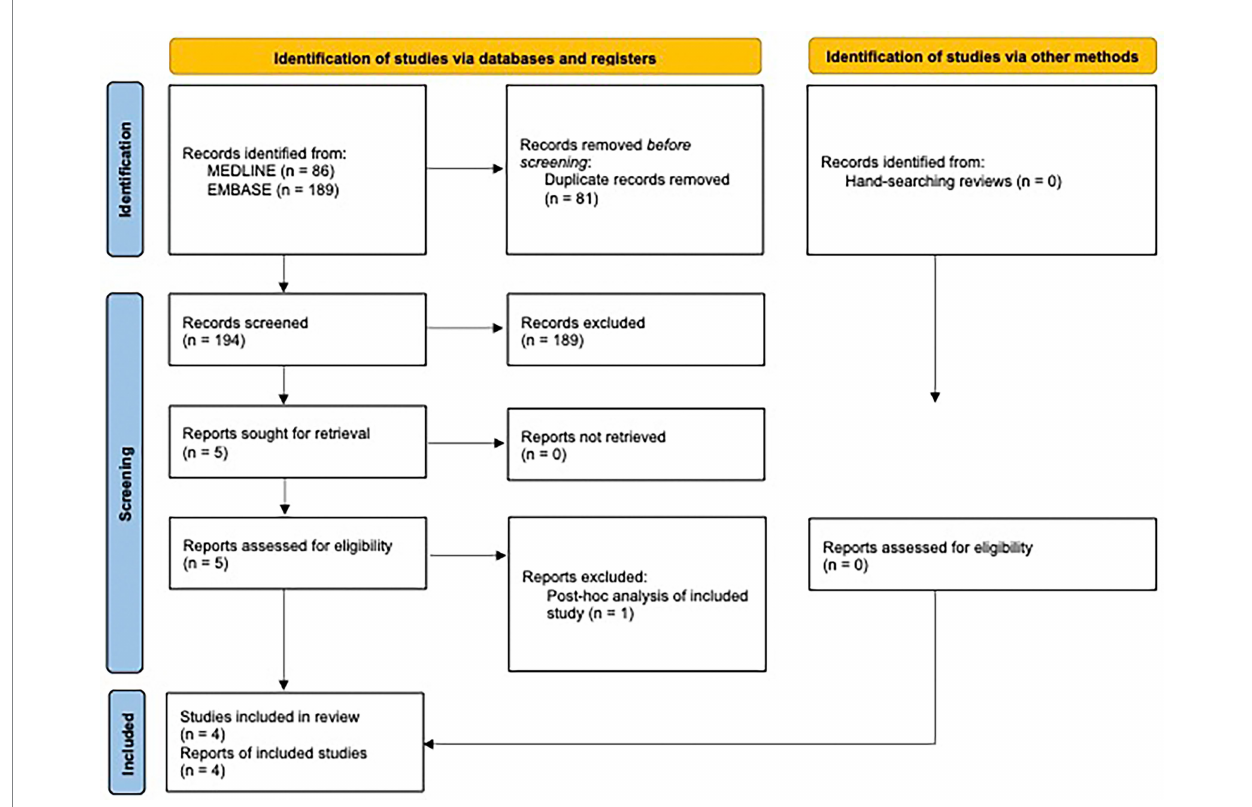
FIGURE 2 PRISMA flow